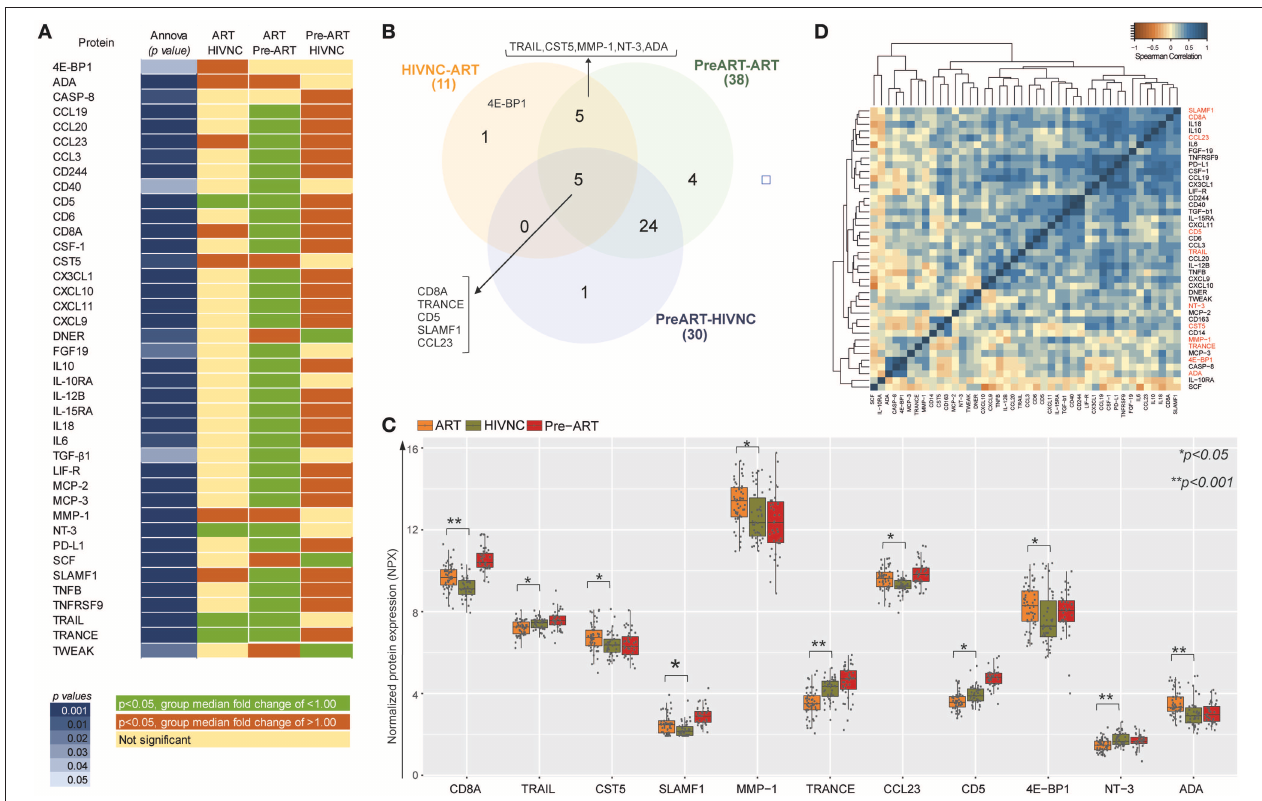
FIGURE 4 | Comparative analysis of the proteins that differed significantly between groups. (A) Proteins that have statistically significant difference ( p < 0.05, Tukey HSD) (in dark blue shade) between at least one of the groups compared (ART vs. Pre-ART, Pre-ART vs. HIVNC and ART vs. HIVNC). (B) Venn diagram showing significantly different protein in the study group. The sum of the numbers in each large circle represents the total number of differentially expressed proteins in plasma in the different groups (HIVNC vs. ART, Pre-ART vs.ART, and Pre-ART vs. HIVNC). The overlapping part of the circles represents significantly different proteins in the indicated groups. (C) Comparative analysis of 11 soluble markers that are significantly different between ART and HIVNC. (D) Heatmap and clustering of significantly different proteins on their protein-protein pair relation by Spearman-correlation in ART patients. * p < 0.05,** p <